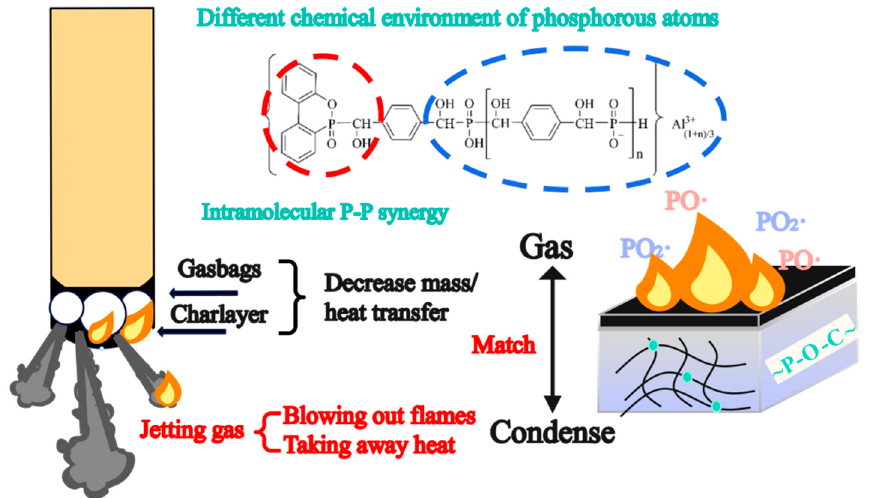
Figure 7. The flame retardant mechanism illustration of HPDAl in EP.